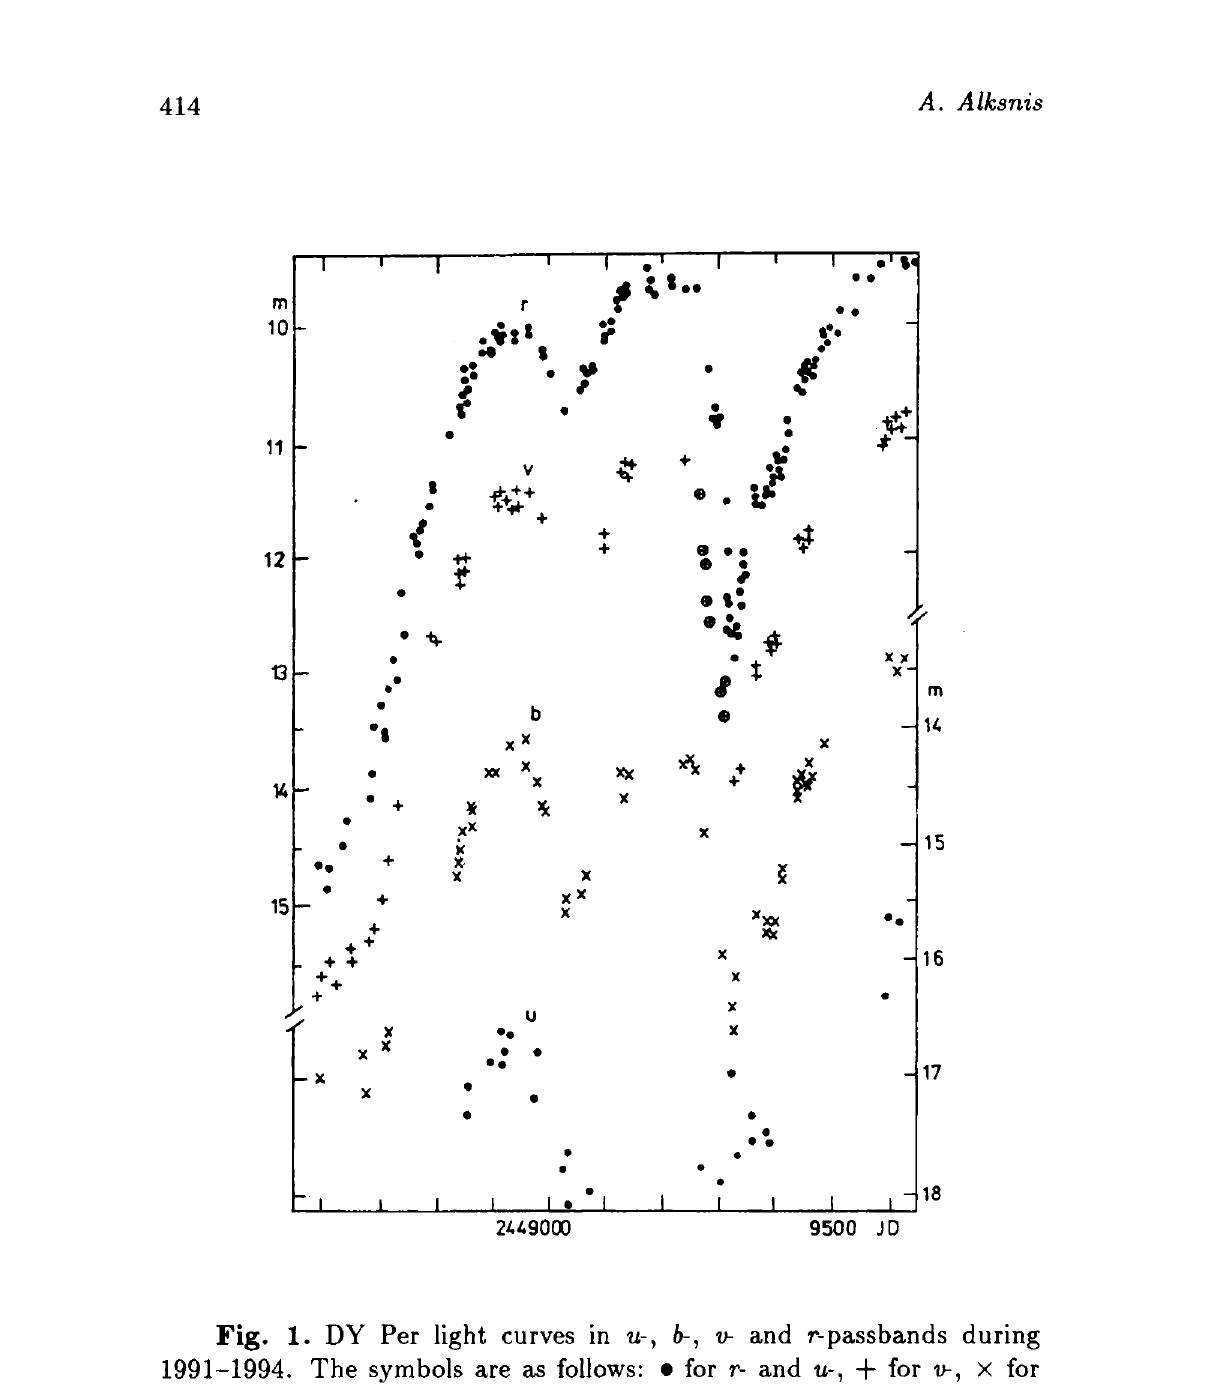
Fig. 1. DY Per light curves in u-, b-, v- and r-passbands during 1991-1994. The symbols are as follows: · for r- and u-, + for υ-, X for ¿-magnitudes and Φ for visual estimates made by G. Poyner, J. Pietz and M. Westlund and communicated to the author by Hurst (1993). The left scale is for r- and v- magnitudes, the right scale is for b- and